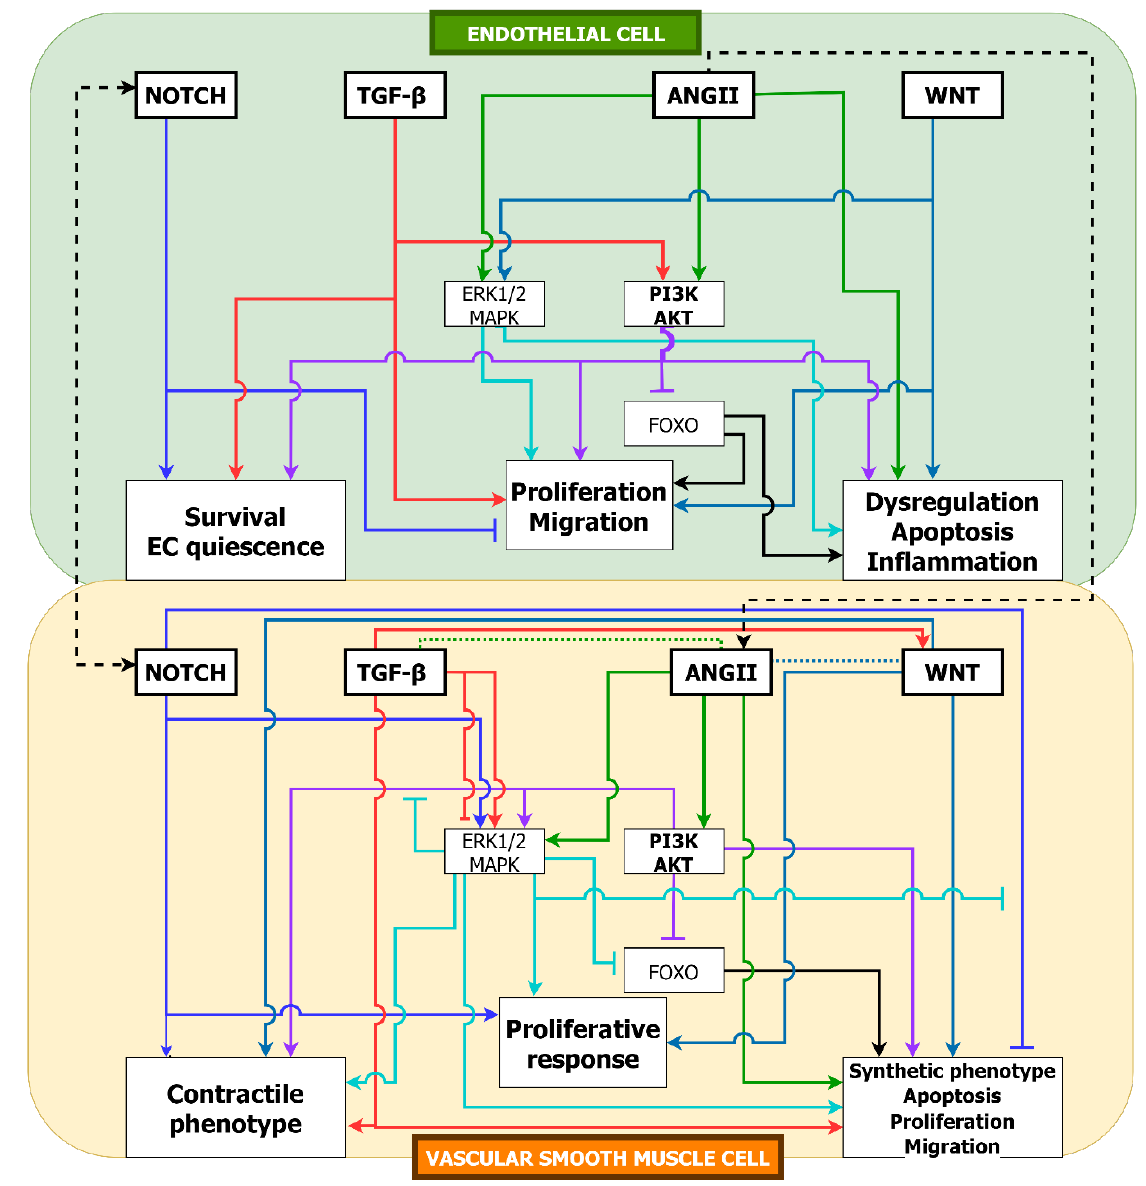
Figure 11. Summary of pathways and direction of activity in promoting different cellular responses in EC and VSMC, via either direct or indirect activation. Arrows indicate activation whereas the stops illustrate inhibition of the pathway/process. Colored dashed lines indicate binding and/or co-signaling. Black dashed line indicates the process involves VSMC-EC interaction. Solid lines correspond different signaling pathways: Red, TGF- β ; Teal, WNT; Purple, PI3K/AKT; Blue, NOTCH; Green, ANGII; Light blue, ERK1/2/MAPK and Black, FOXO. This figure illustrates the extend of signaling redundancy. Additionally, the PI3K/AKT and MAPK pathways are often common intermediaries. For details of signaling pathways refer to the text.